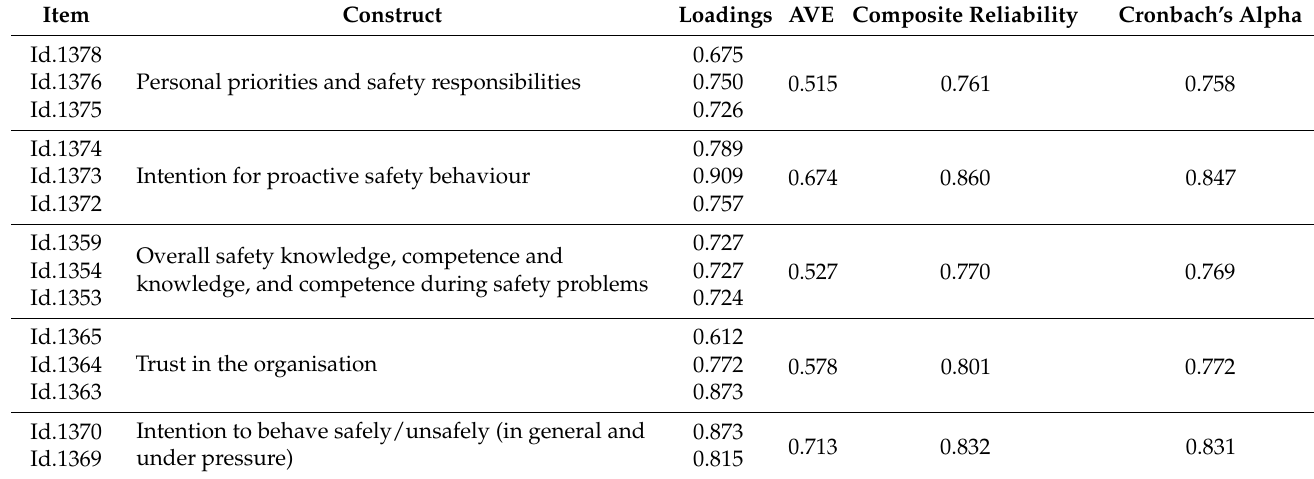
Table 6. Results CFA—Psychological domain (n = 444)—assessment of convergent validity and reliability.